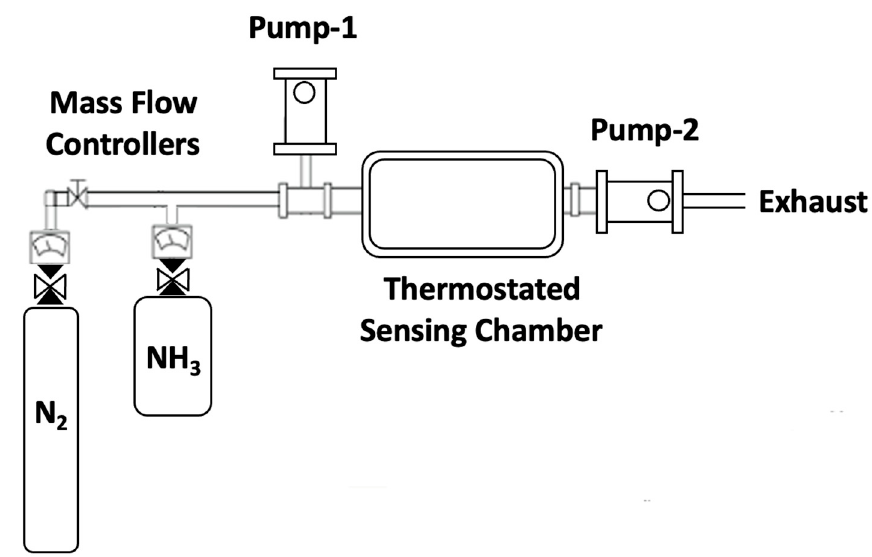
Figure 2. Schematic diagram of the setup for ammonia gas sensing.